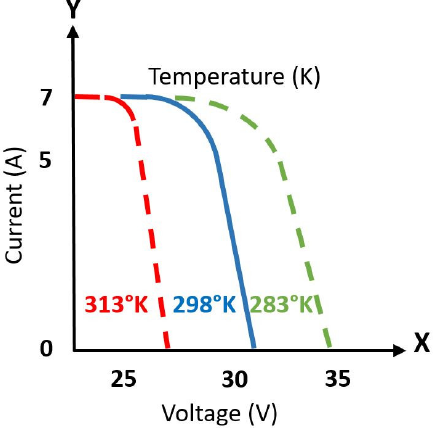
Figure 2. Ideal, Standard, and Critical Temperature Variation.